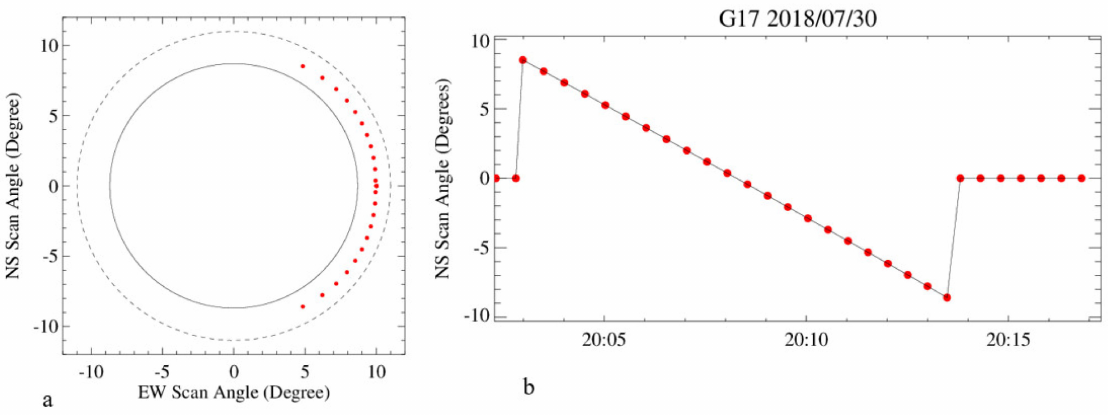
Figure 3. ( a ) Locations of the G17 spacelook events (in red dots) for the timeline between 20:02 and 20:17 UTC on 30 July 2018. The spacelook positions are located east to the Earth for this timeline. ( b ) Time series of the NS scan angles for the spacelook scenes of this